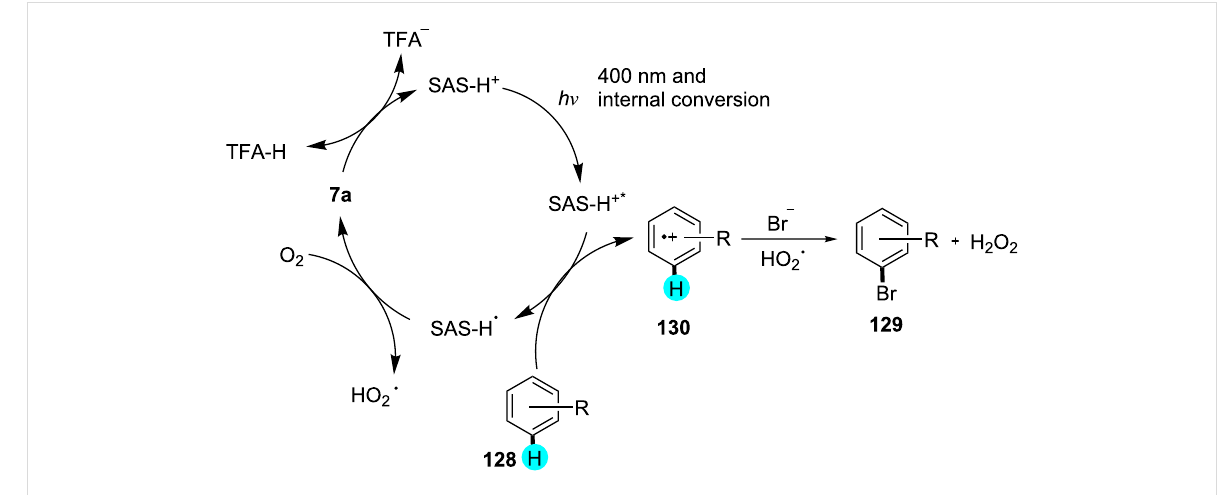
Figure 21: Proposed mechanism for the synthesis of monobrominated compounds.